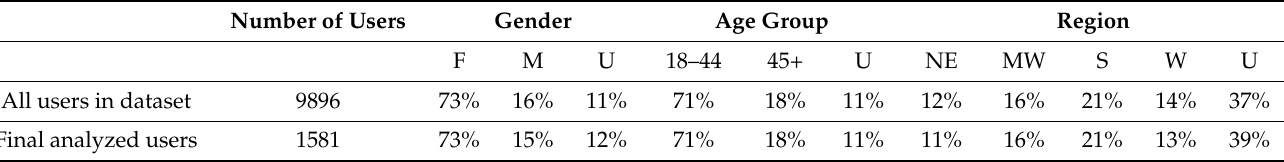
Figure 1. Example of MyFitnessPal App’s interface [13]. Table 1. Demographic description of the users in the MyFitnessPal Public